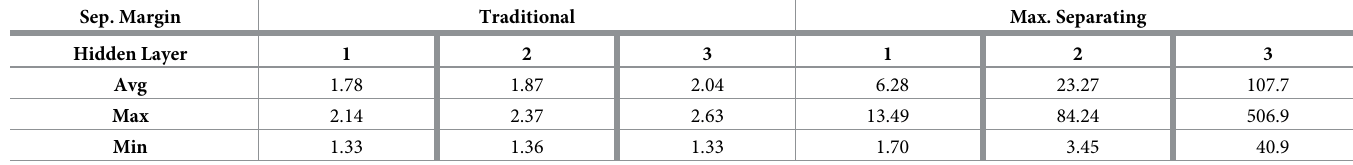
Table 3. Comparison of separating margins between traditional and optimally-separating ANNs, for the Iris classification problem. Sep.